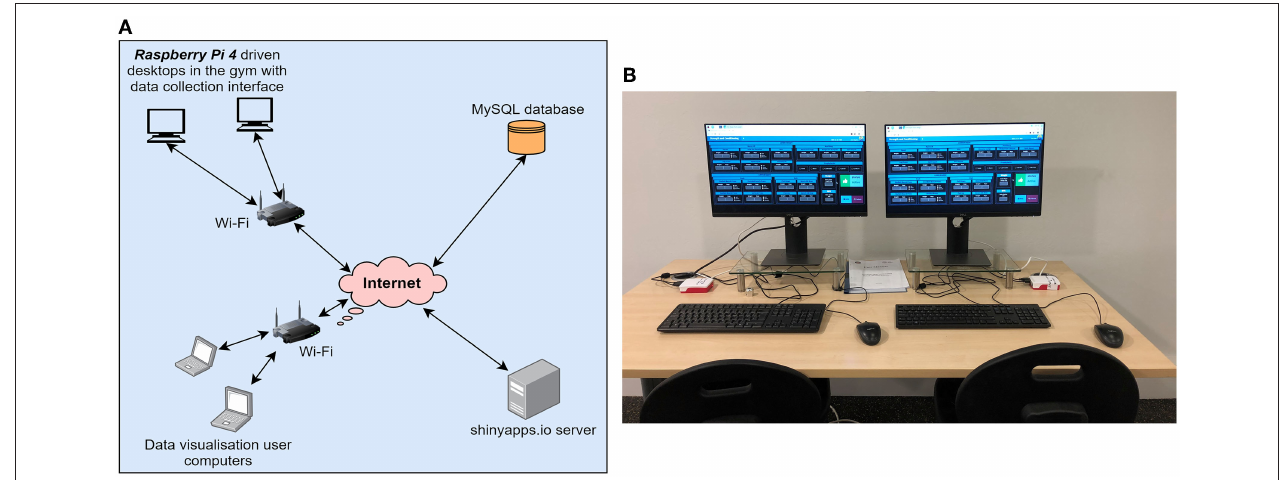
FIGURE 6 | Implemented system overview (A) network model (B) data collection interfaces inside the gym.